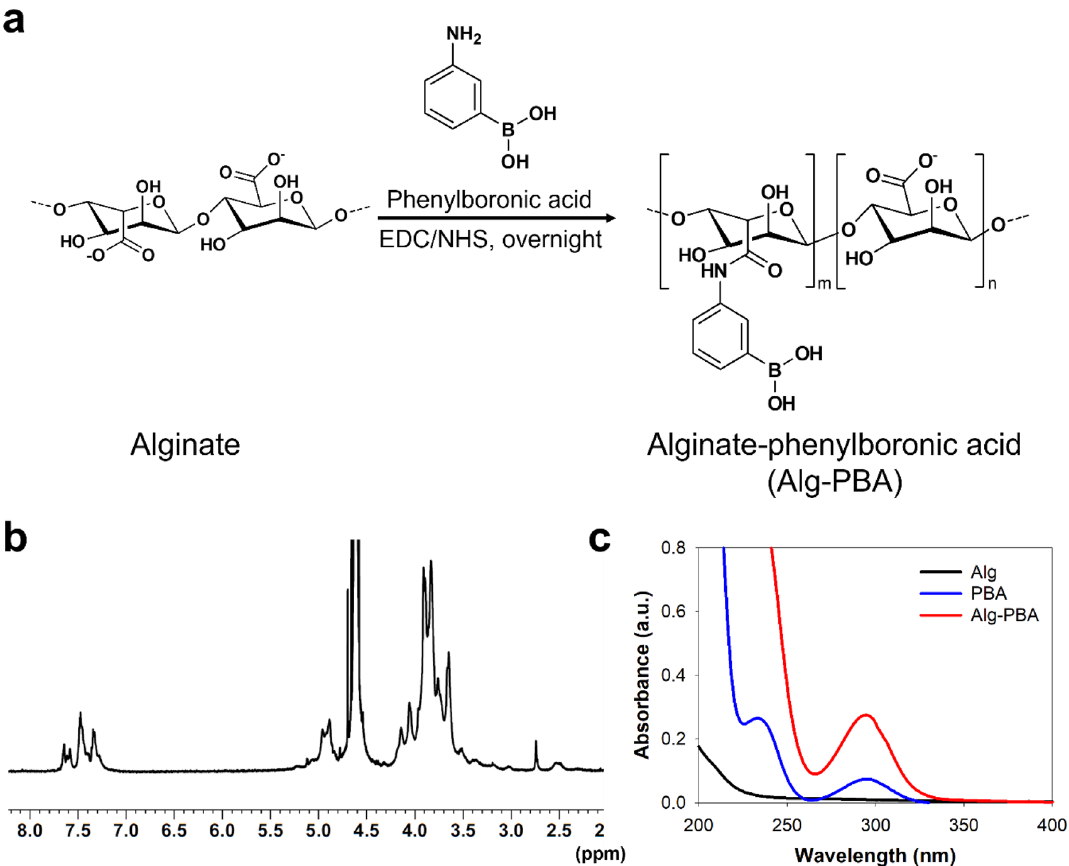
Figure 1. ( a ) Synthesis and chemical structures of phenylboronic acid-conjugated alginate (Alg-PBA), ( b ) 1 H NMR spectrum of Alg-PBA. c ) UV–Vis spectra of alginate (black), PBA monomer (blue), and Alg-PBA